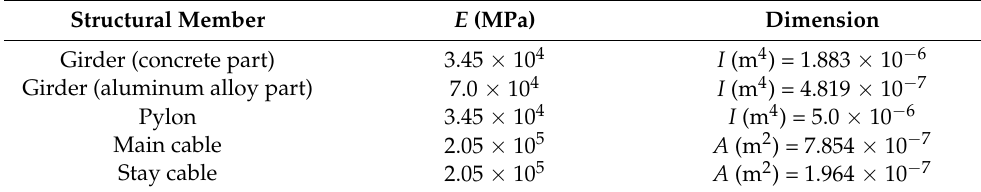
12 of 21 Figure 6. Dimensional properties of the test model of the bridge (unit: m). Researchers [18,19] have studied the structural behavior of this bridge by building a 1:100 bridge model in the laboratory. Both the finite element results and test results along with more detailed information are provided in the literature [18,19]. The software used in the finite element analysis is ANSYS. Both the beam and pylon were using the 3D